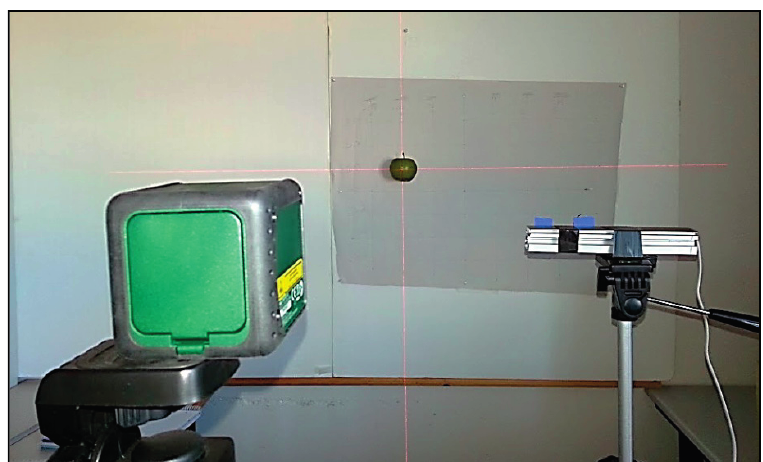
Figure 2. Experimental setup for grid